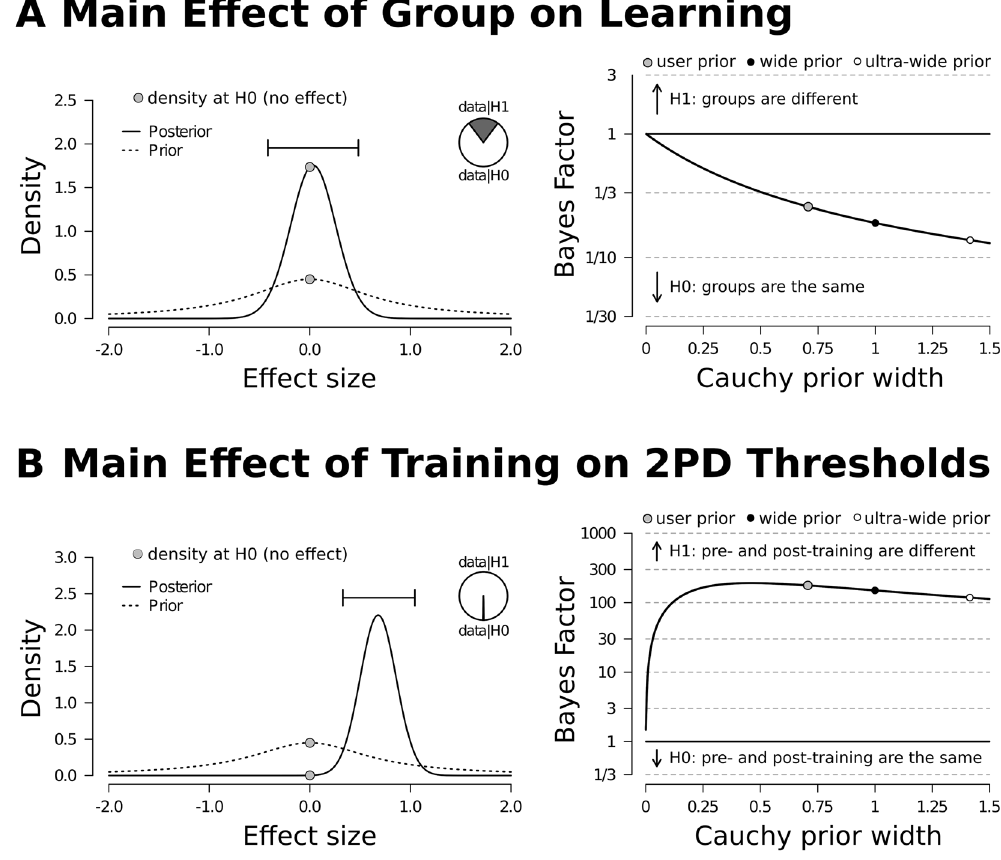
Figure 4. Overview of Bayesian statistics. The prior distributions are shown as dashed lines, and the posterior distributions are shown as solid lines. The grey dots indicate the height of the curves (density) at the null hypothesis (H0). The robustness plots (right side) for the chosen priors (default value = 0.707) show how the Bayes factor (y-axis) changes for a wide range of prior width (x-axis). A Bayes factor of 1 or greater represents evidence in favor of the alternative hypothesis (H1), and a Bayes factor below 1 represents evidence in favor of the H0. ( A ) A Bayesian independent samples t-test was calculated to test the main effect of group on learning. The higher dot on the posterior distribution indicates that the Bayes factor supports the H0 (groups are the same). When testing the robustness of the results, the width of the prior increases, whereas the Bayes factor decreases, indicating that also wider priors represent evidence in favor of the H0. ( B ) A Bayesian paired